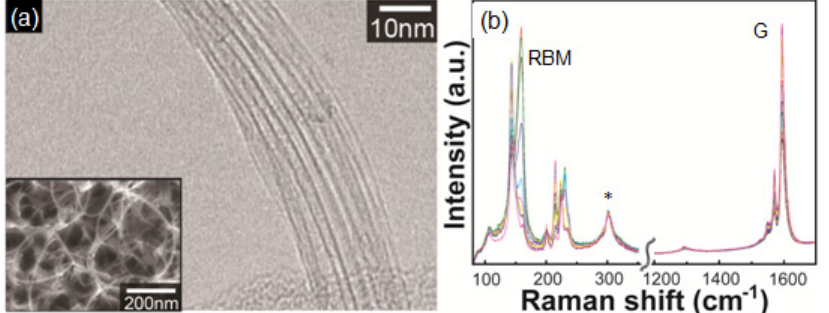
Figure 1. ( a ) Transmission electron microscopy image of SWCNTs grown using Au nanoparticles. Inset is a scanning electron microscopy image of the sample; ( b ) Raman spectra (overlain from 20 measurement points) of the sample. The excitation wavelength of the Raman spectra was 785 nm. The peak denoted by * is originated from Si